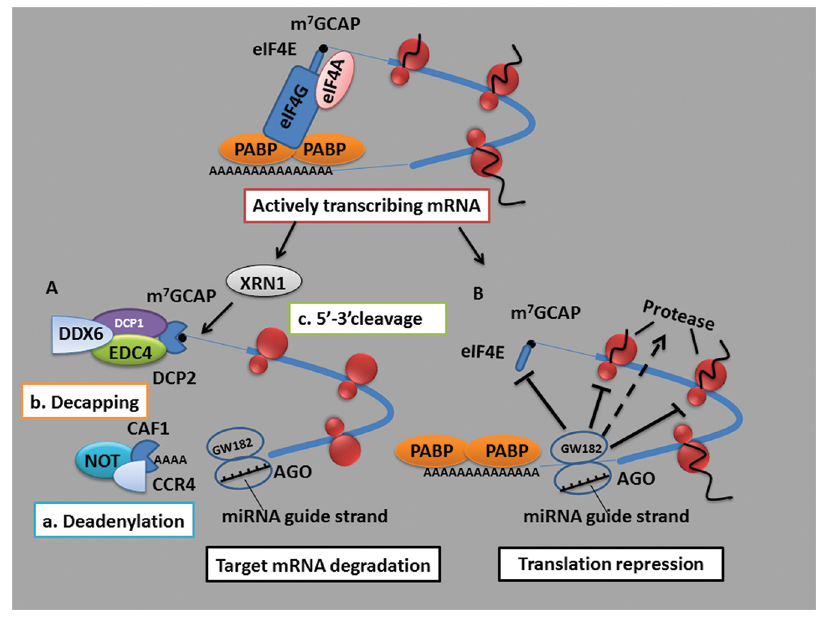
Figure 2. Process for miRNA-mediated gene regulation. The mechanism of two types of microRNA-mediated gene regulation are shown: (A) targeted mRNA degradation: De- capped mRNAs are targeted by XRN1 (cytoplasm) that leads to degradation of mRNA. miRNA mediated mechanism affects the stability of mRNA and causes removal of the ends of mature mRNA in the cytoplasm and targeted mRNA is degraded (B) translation inhibition. Figure reproduced with permission of Frontiers Research Foundation. Sethi A, Kulkarni N, Sonar S, Lal G. (2013) Role of miRNAs in CD4 T cell plasticity during inflammation and tolerance. Front. Genet. 4:8 (cited as reference [39] in the current